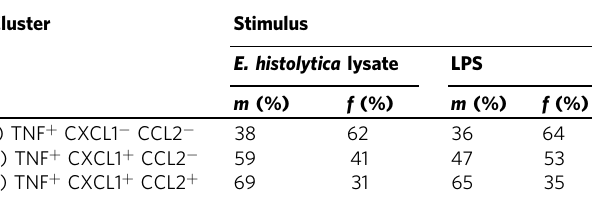
Table 2 Cytokine distribution of HSNE